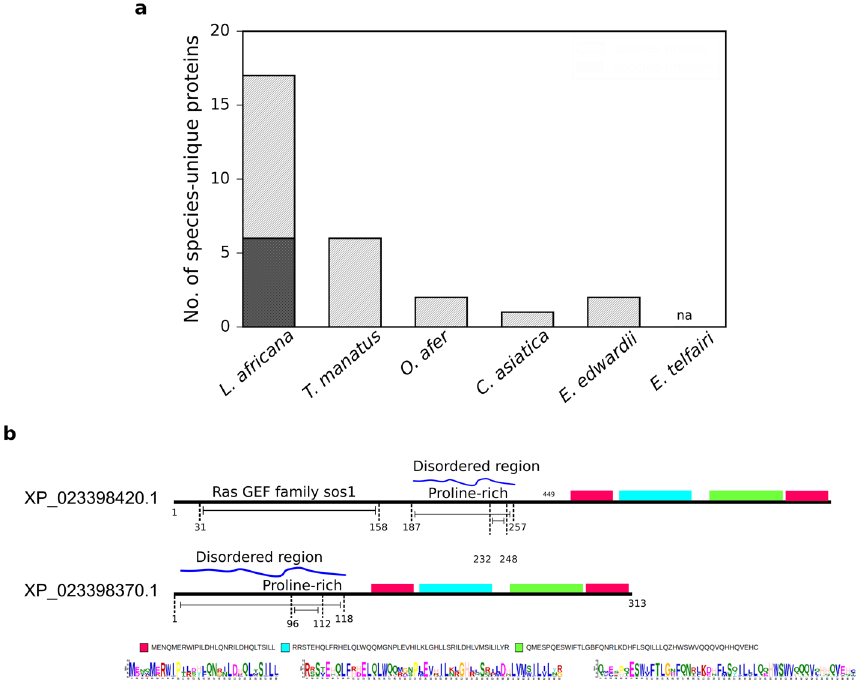
Figure 3. L. africana has the highest number of species-unique proteins in Afrotheria. ( a ) Bar plot shows the total number of species-unique proteins in each of the Afrotherian species (‘/’ symbol filled). Using a combination of approaches, function was predicted and improved for 6 of the 17 L. africana -unique proteins (crossline filled) ( b ) Sequence signatures of XP_023398370.1, an L. africana -unique protein (bottom) and its closest paralog—RGL protein (XP_023398420.1) (top) show similarities that reveal a potential role in protein- binding. Sequence motifs highlighted in different colors are common motifs shared between the paralogs that were recognized using MEME algorithm 52 . Each colored motif is expanded at the bottom of the